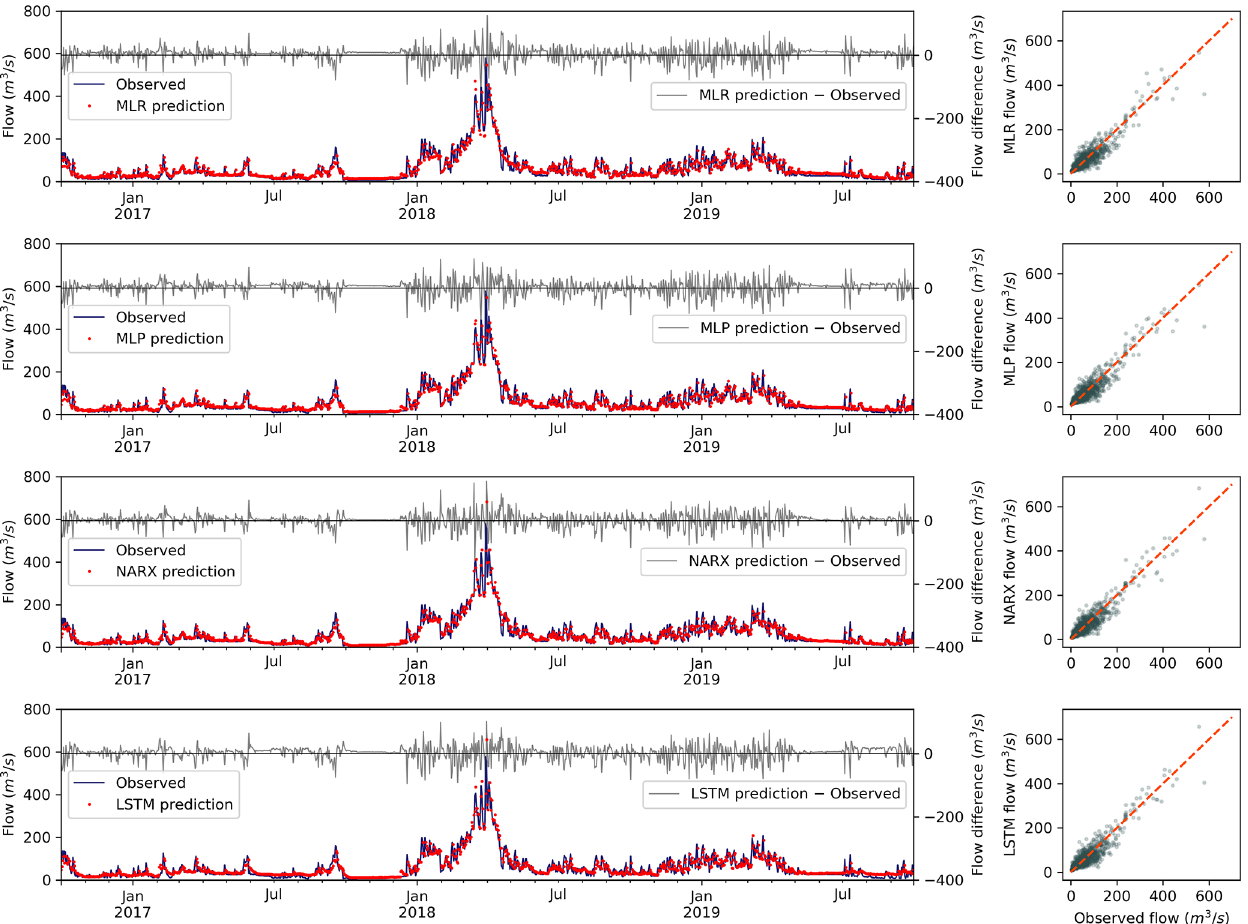
Figure 9. Time series (left panels) and scatterplots (right panels) for Belesar Dam using the test dataset obtained with the proposed